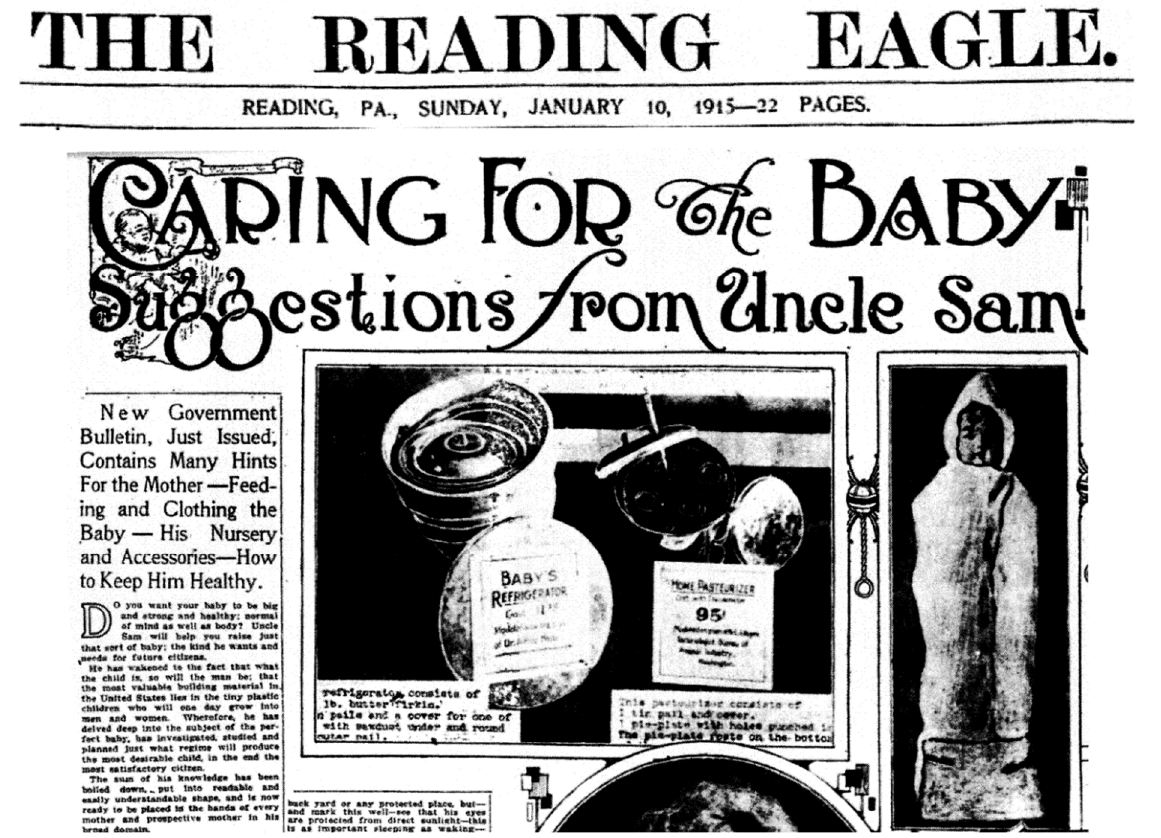
Figure 2. 10 January 1915 Edition of the Reading (Pennsylvania) Eagle .